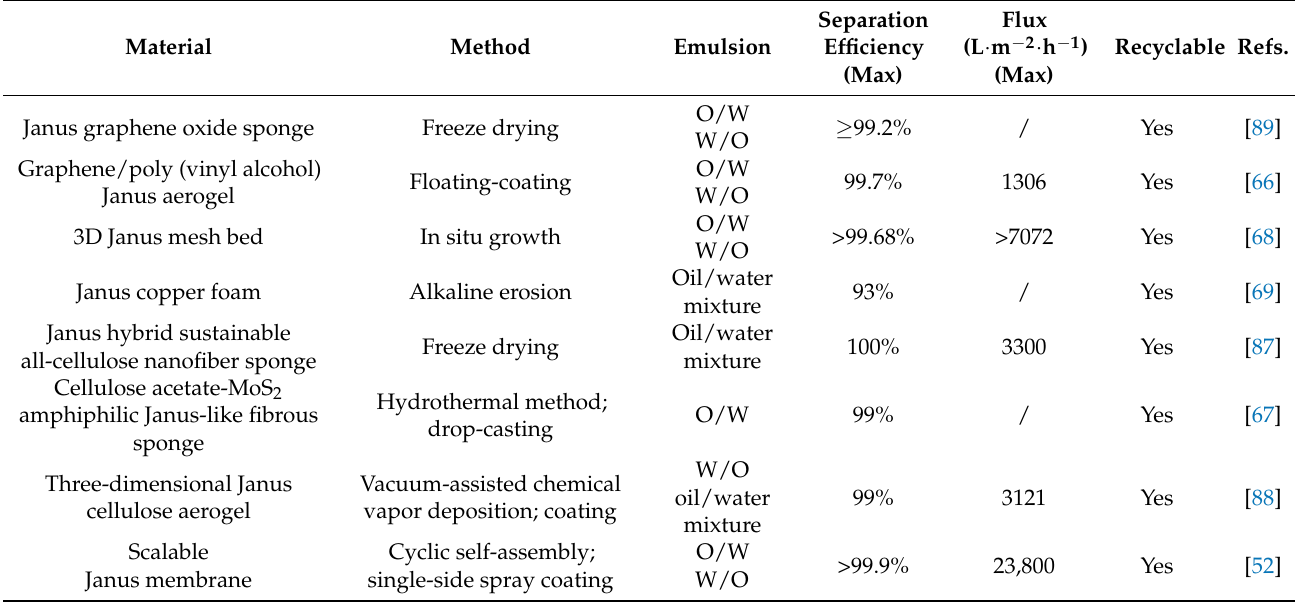
Table 4. Summary of 3D Janus materials with asymmetric wettability for oil–water